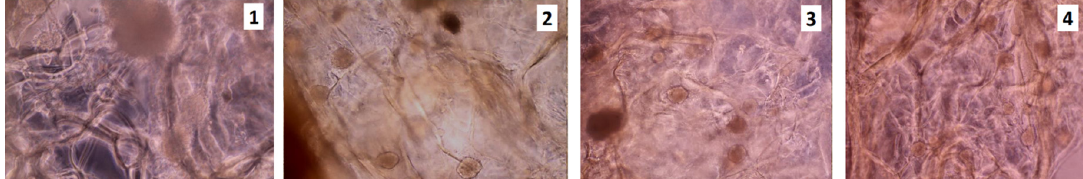
Figure 9. HCT116 cell culture on the unsterilized scaffolds, rinsed in PBS; 5th day of the cell culture (sample 1—chitosan crosslinked with adipic and malonic acid; sample 2—chitosan crosslinked with adipic and L -glutamic acid; sample 3—chitosan crosslinked with adipic, L -glutamic and malonic acid; sample 4—chitosan crosslinked with adipic and levulinic). Molecules 2017 , 22 , x FOR PEER REVIEW